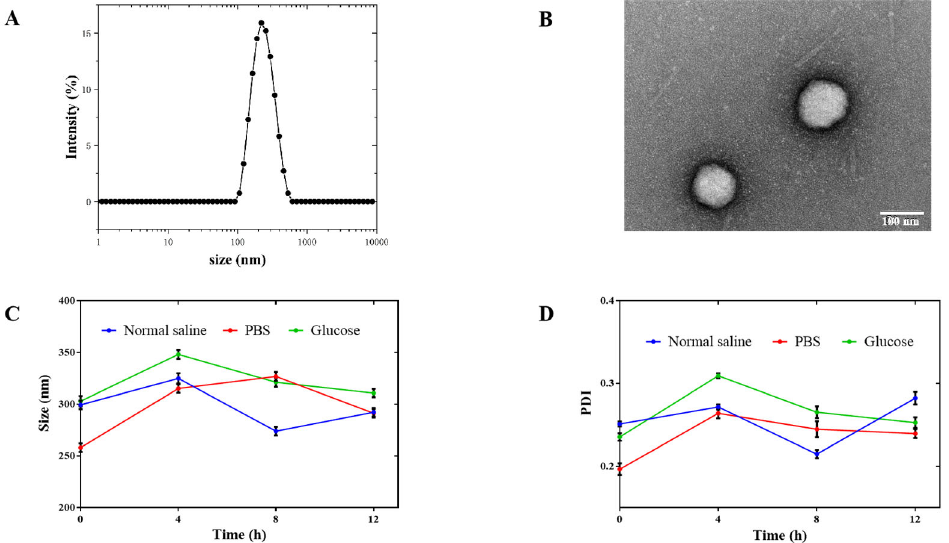
Figure 1. Particle size distribution curve of PPY NPs ( A ); TEM images of PPY NPs ( B ) (Scale bar 100 nm); the size ( C ) and PDI diagrams ( D ) for the stability of PPY NPs in physiological media (n = 3).